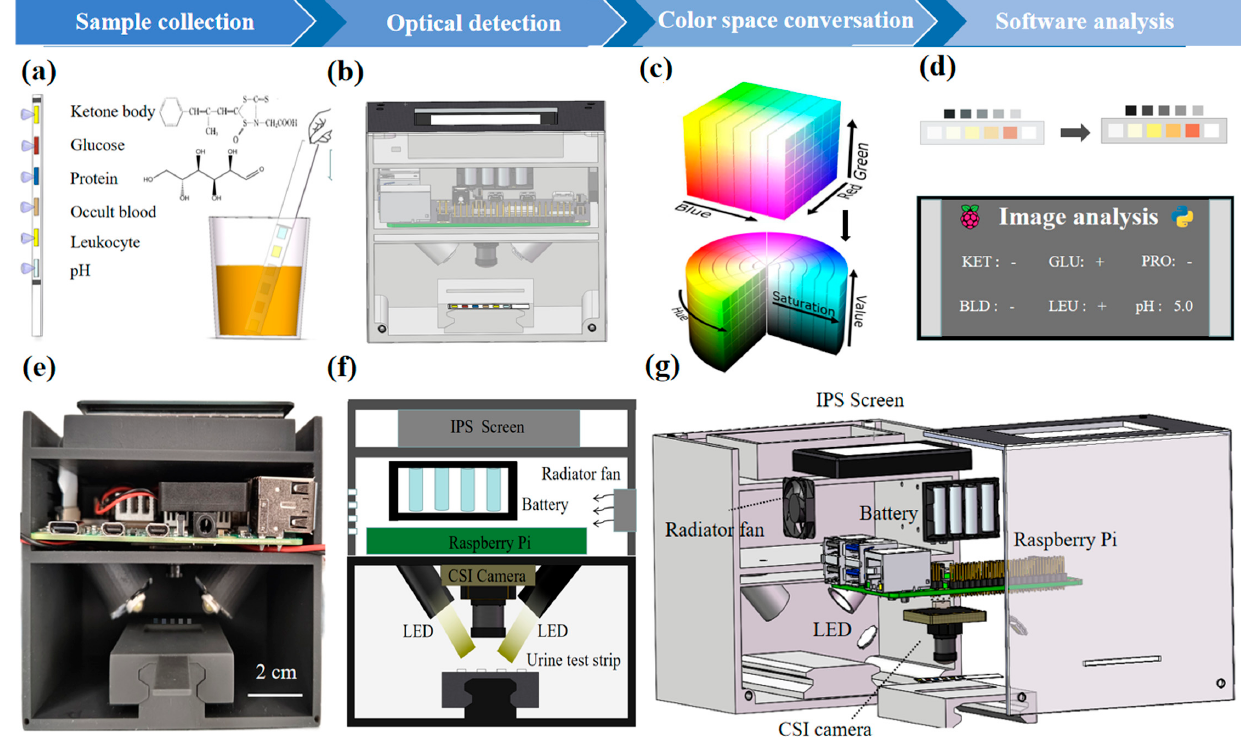
Figure 1. Schematic illustration of an optical POCT-based colorimetric analysis device for urinalysis of reagent strips via the RGB-to-HSV color conversion method. ( a ) Sample collection; ( b ) optical detection based on a POCT device; ( c ) conservation from RGB color space to HSV color space; ( d ) image analysis using software installed on Raspberry Pi; ( e ) physical map of the optical device; ( f ) diagram of the optical device; ( g ) expanded views of the optical device designed using SolidWorks software.